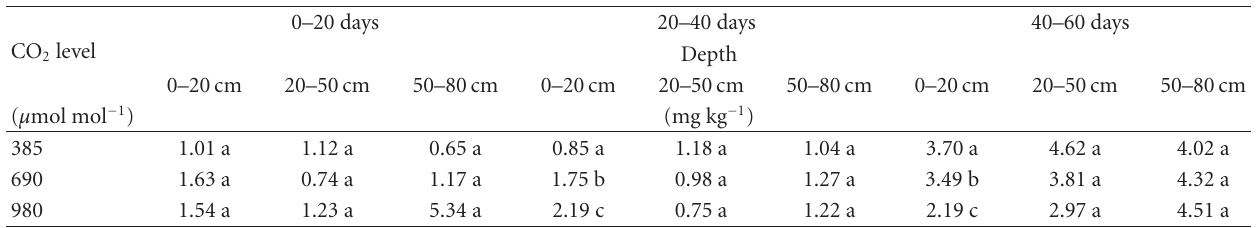
Table 3: E ff ect of atmospheric CO 2 concentration on soil C turnover during a 60-day soil incubation at three soil depth increments † . CO 2